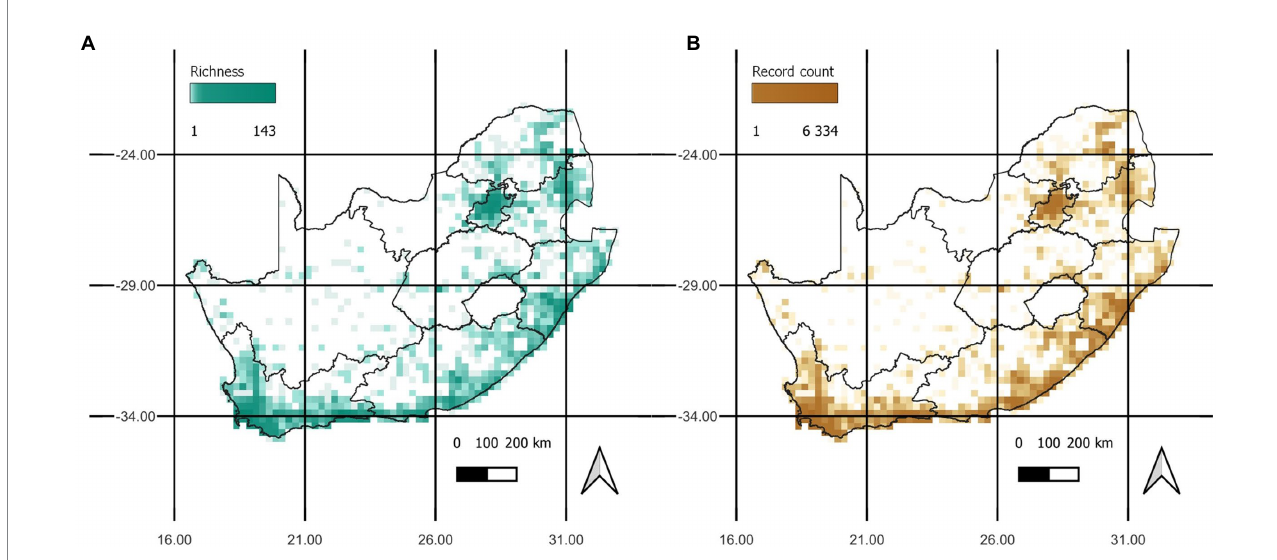
FIGURE 1 (A) The distribution of focal species richness, presented as the number of species per grid cell. (B) The distribution of record counts per grid cell, which relates to sampling effort for focal species. The similar patterns in the two plots highlight that the richness per cell may be biased by the sampling effort in those